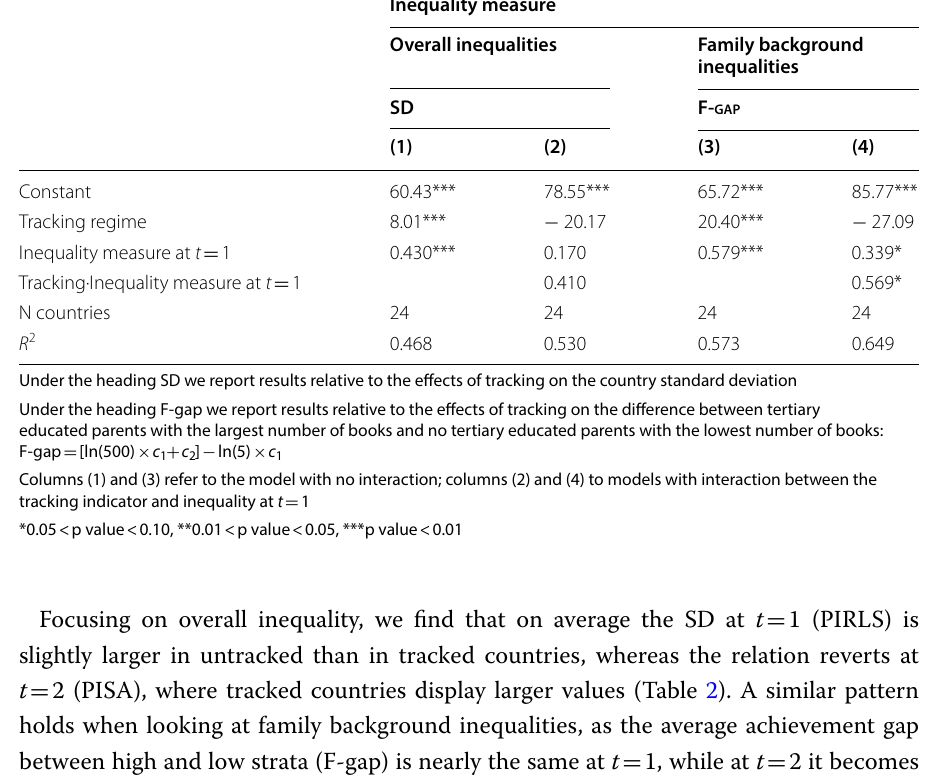
Table 3 Second step results. Cross‑country regression models